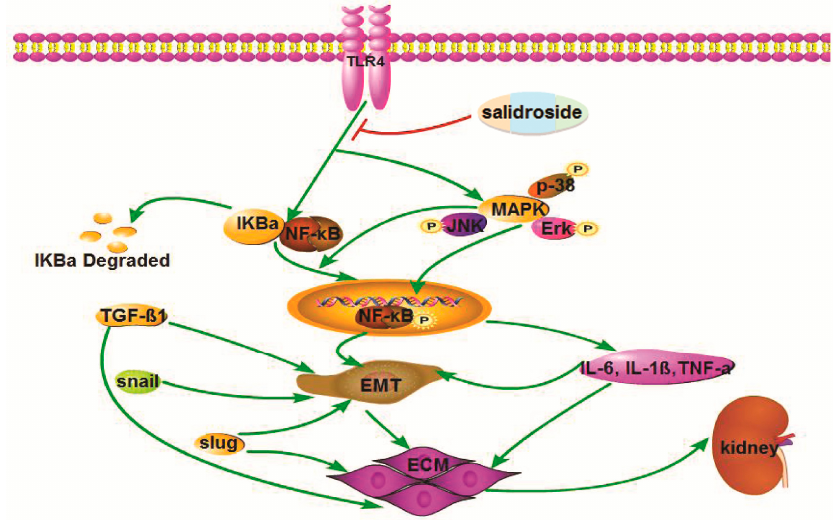
Figure 8. Schematic illustration of the role and mechanism of Sal when ameliorating renal fibrosis. Sal suppresses the TLR4/MAPK/NF- κ B signaling pathways to inhibit the inflammatory response and EMT process.